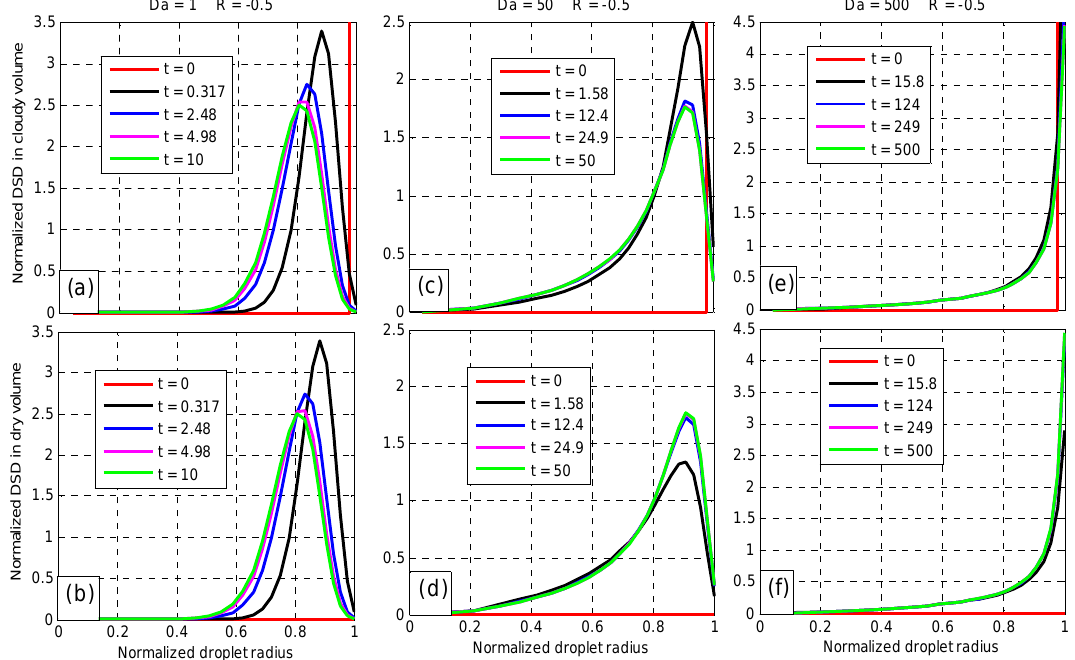
Figure 11. Examples of DSD evolution in the initially cloudy volume ( e x = 1 / 4 ) (upper row) and in the initially dry volume ( e x = 3 / 4 ) (lower row) at R = − 0 . 5 and at different values of Da